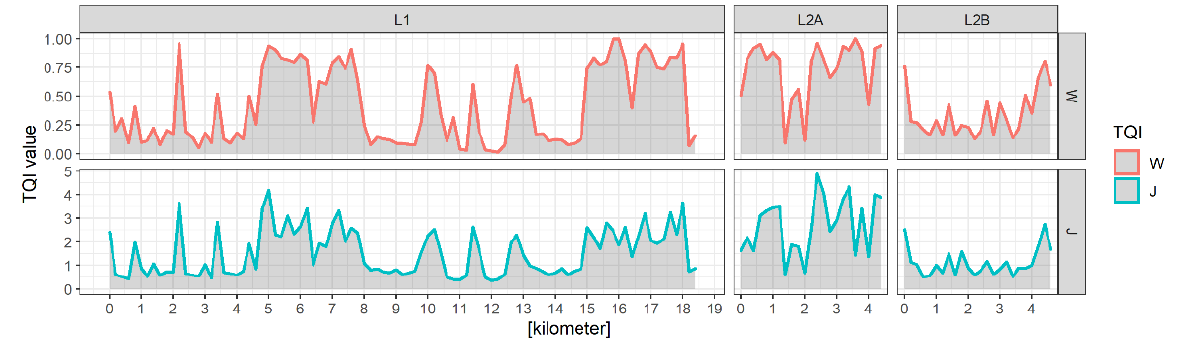
Figure 9. Distribution of the W and J indices for 200m-long analytical segments.